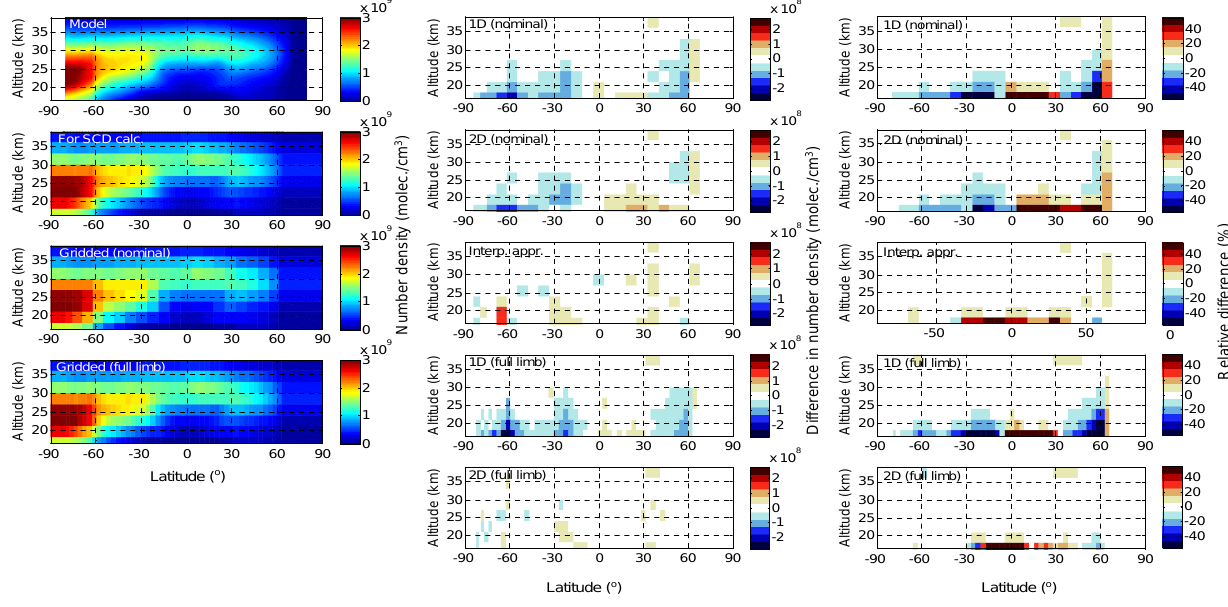
Fig. 15. Left panels: NO 2 number density field simulated by EMAC atmospheric chemistry general circulation model for 15 December 2007 (top), gridded for the simulation of SCDs with fine horizontal resolution (second row), and gridded to the resolution of the SCIAMACHY limb measurements in the nominal and full limb operational modes (third and bottom row). In the middle and right panels absolute and relative differences between the NO 2 distribution retrieved from the simulated SCDs and the true (simulated) number density field are shown. The first three rows from top show results for the simulated measurements with the distance of 7.5 ◦ of the orbital cycle between consecutive scanning sequences. From top to bottom the differences plotted are for the 1-D approach, the 2-D approach and the interpolation approach. In the two bottom rows, the results for the distance of 3.3 ◦ (i.e. full limb mode) are shown for the 1-D and 2-D approach.